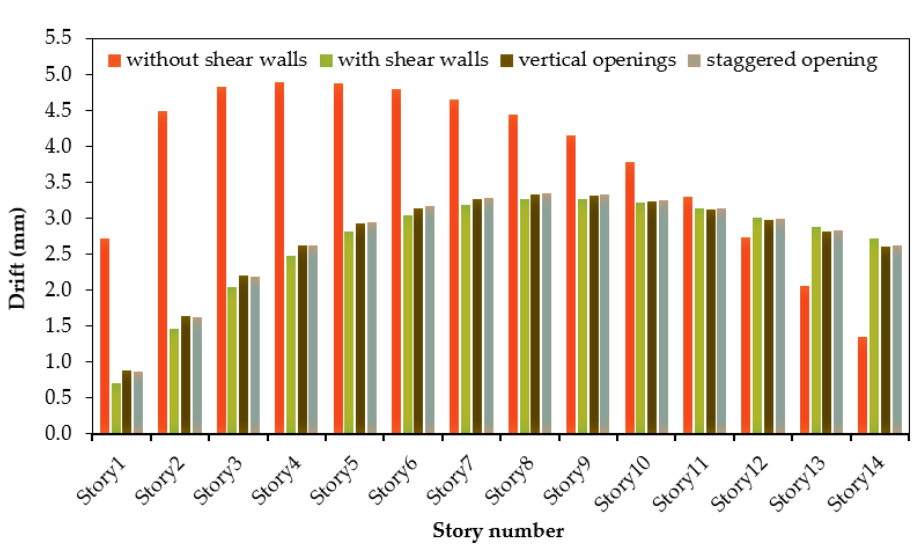
Figure 13. Story drift of the models: static analysis and X-direction analysis.